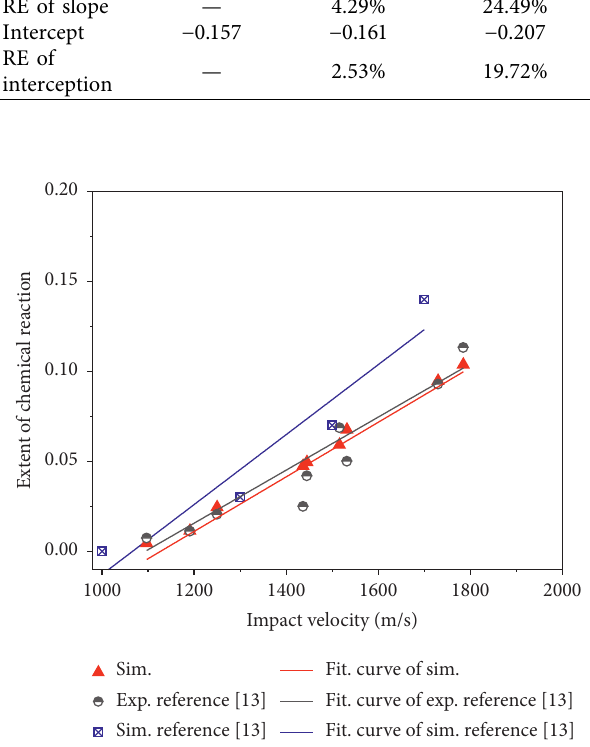
Figure 6: Direct ballistic test data [13], and numerical simulation results in this study and [13], for different impact velocities.